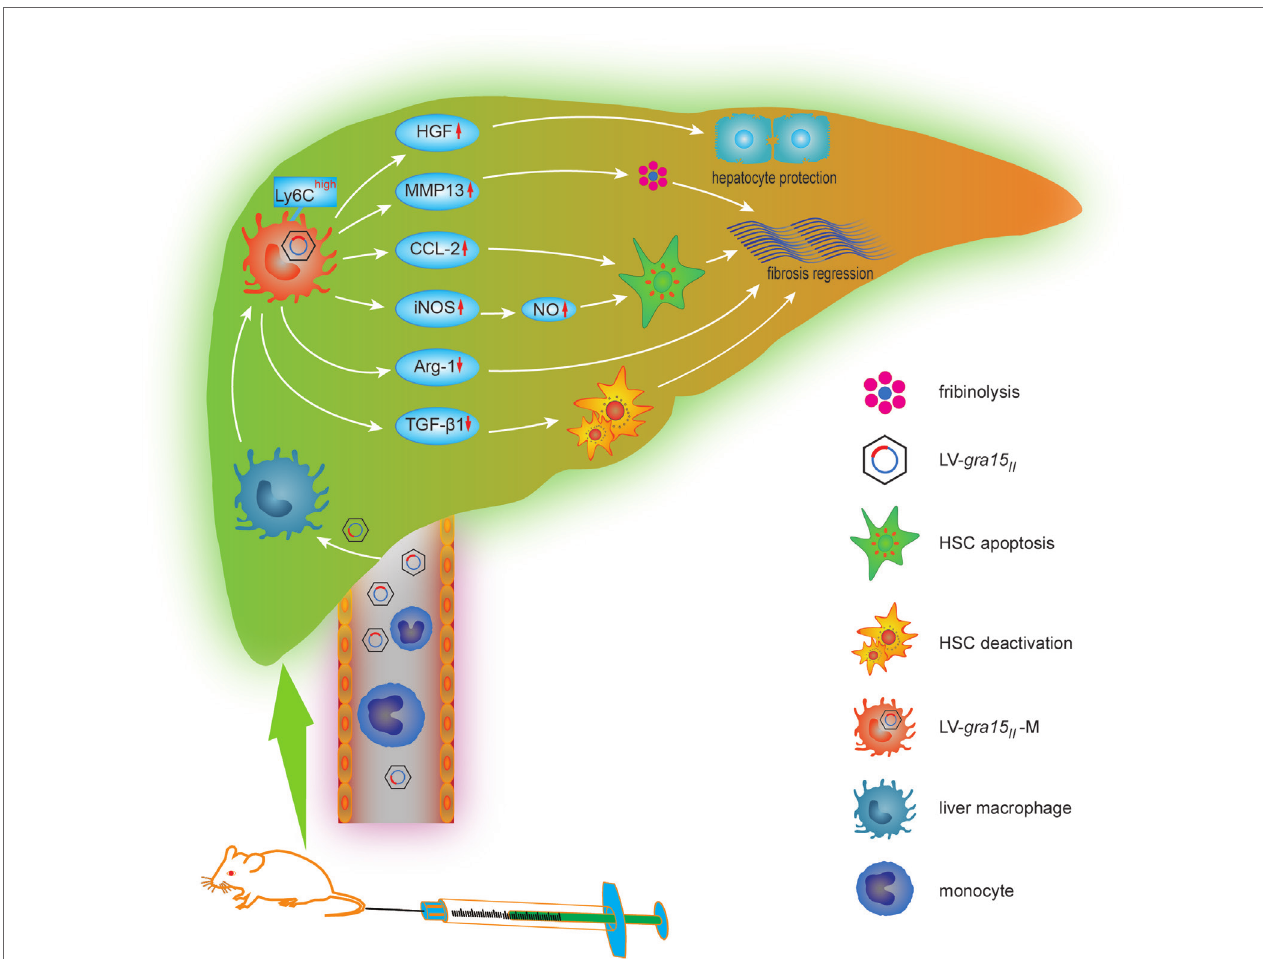
FigUre 9 | The cellular and molecular mechanisms by which lentiviral vector (LV)- gra15 II delivery mitigates schistosomiasis liver fibrosis. LV- gra15 II infects macrophage in fibrotic liver after being injected via schistosomiasis mice tail vein and transduces liver macrophage into LV- gra15 II -M which presents a M1 macrophage-like phenotype. The LV- gra15 II -M with a high expression of lymphocyte antigen 6 complex (Ly6C) increases the production of matrix metalloproteinase 13 (MMP13), C-C motif chemokine ligand 2 (CCL2), inducible nitric oxide synthase (iNOS), nitric oxide (NO), and decreases the generation of Arg-1, transforming growth factor-beta1, which results in fibrosis mitigation through dissolving collagen protein, inducing HSC apoptosis or deactivation and reducing fibrogenesis. Moreover, the LV- gra15 II -M protects hepatocytes against apoptosis through secreting hepatocyte growth